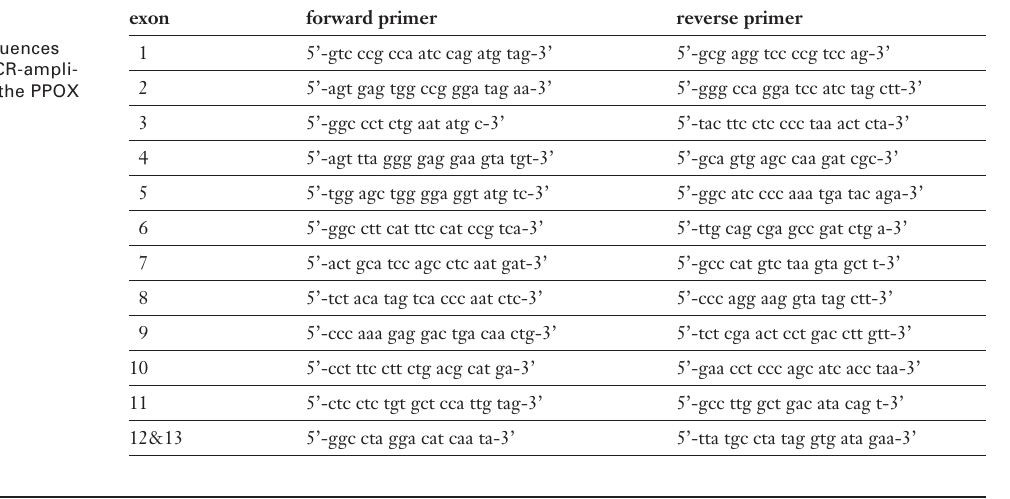
Figure 1 Three novel PPOX gene mutations in Swiss patients with variegate porphyria, A : mutation G11D in patient VP-1; B : mutation 1041-1042 ins T, stop+2 in fam- ily VP-2 and C : mutation 1262- 1263 ins 22 bp, stop+21 in patient VP-8. D : a portion of the PPOXgene indicating the sequence of the 22bp insertion be- tween nucleotide po- sition 1262 and